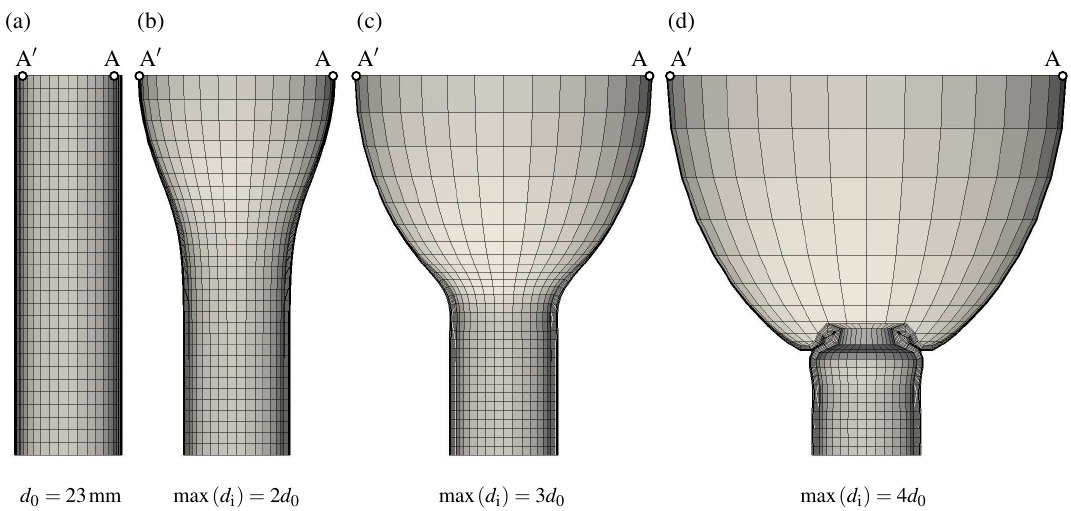
Figure 4. Predicted shapes during Abdominal Aortic Aneurysm (AAA) expansion. ( a ) Normal aorta at homeostasis with inner diameter d 0 = 23.0 (mm); Configurations ( b – d ) show AAAs at maximum inner diameters of 2 d 0 , 3 d 0 , and 4 d 0 ,